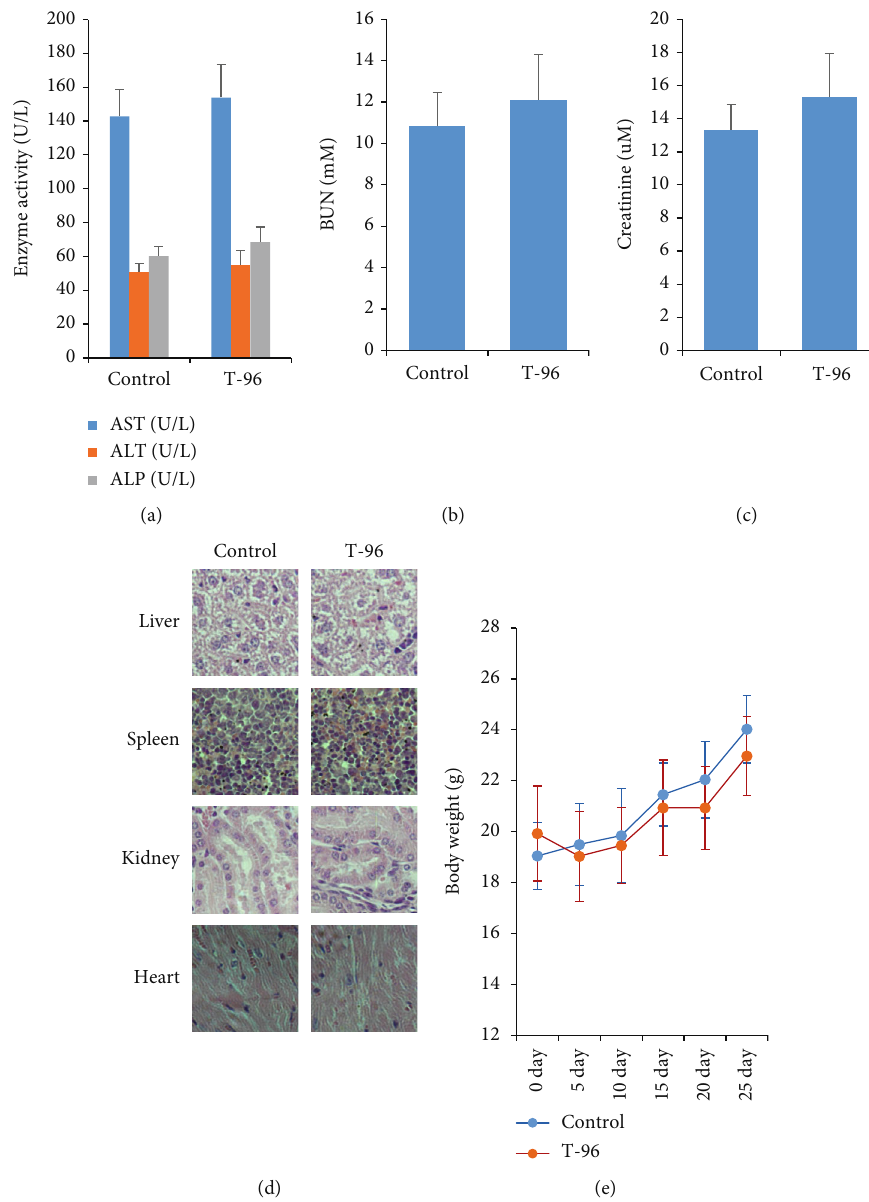
Figure 6: T-96 did not show signi fi cant organ toxicity in mice. (a), T-96 did not show signi fi cantly hepatotoxicity; (c, d) T-96 did not show signi fi cantly nephrotoxicity; (d), T-96 did not show signi fi cant organ toxicity by HE staining; (e), T-96 did not signi fi cantly reduce mouse body weight. Values are statistically signi fi cant at ∗ P < 0 : 05